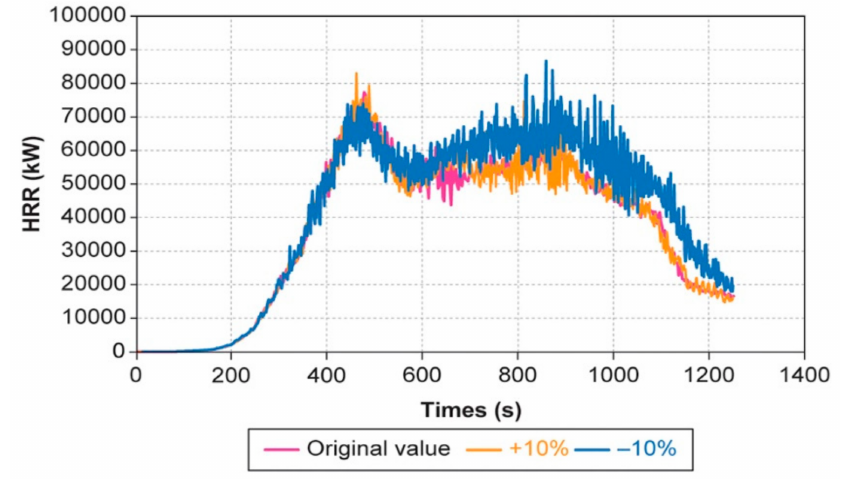
Figure 14. CO yield effects on